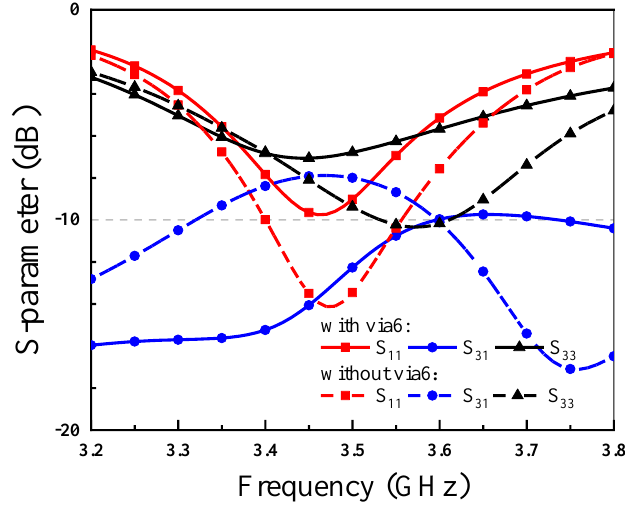
Figure 3. Simulated S-parameter of Ant1 and Ant3 with and without Via6.